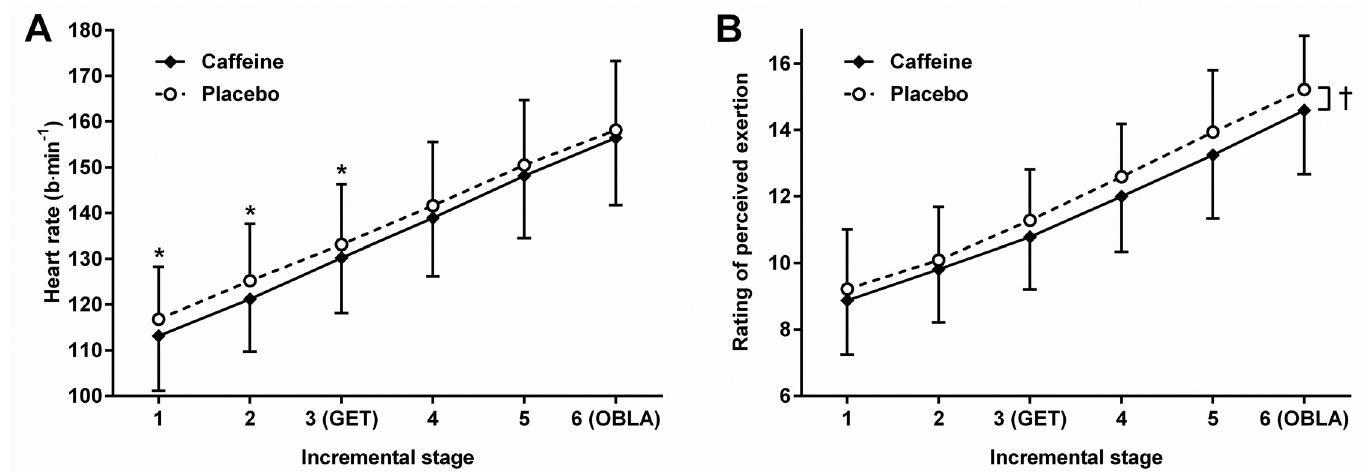
Fig 2. The effects of caffeine supplementation on heart rate (A) and ratings of perceived exertion (B) during submaximal incremental exercise. Values are means; bars are standard deviations . GET = Gas exchange threshold; OBLA = Onset of blood lactate accumulation. † = significant main effect of supplement; * = significant differences ( p < 0.05) at the same exercise intensity.